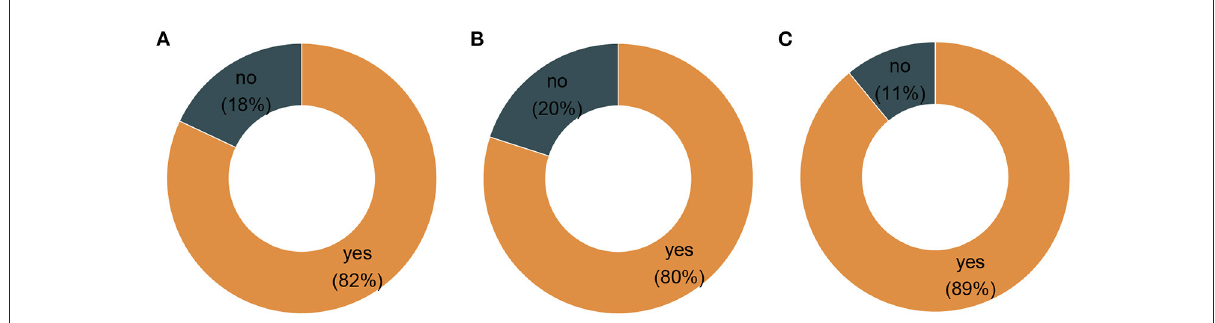
FIGURE1 Proportions of vaccination per region of the study area. (A) Combined region vaccination rate. (B) Southern Arizona vaccination rate. (C) Central Arizona vaccination rate.